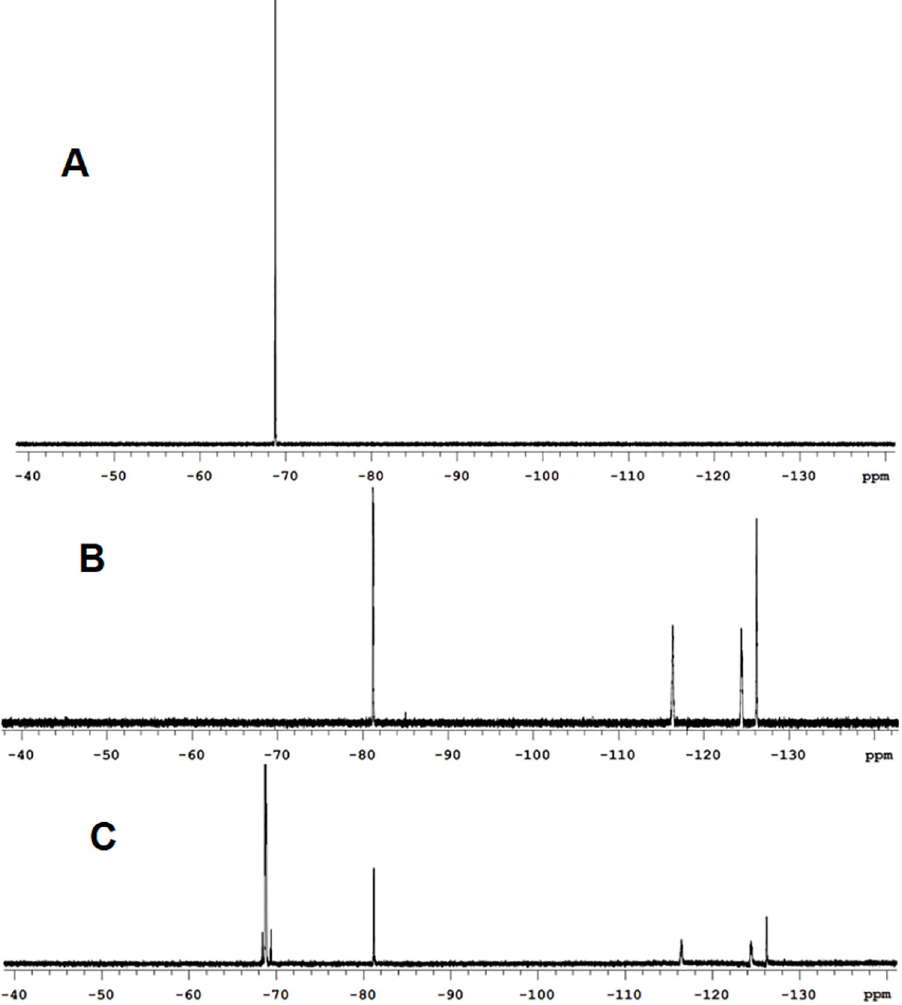
Fig 7. 19 FNMR overlays showing the presence of the surfactant with the Hx dissolved in the low molecular weight fluid (fluid B). (A) A single peak that comes from the C F 3 CH 2 CH 2 - from the fluorinated fluid. (B) Four peaks that correspond to the fluorine of the Hx 19 FNMR of a homogeneous 4% solution (v/v) of the surfactant in the fluorinated fluid exhibiting the signals from both